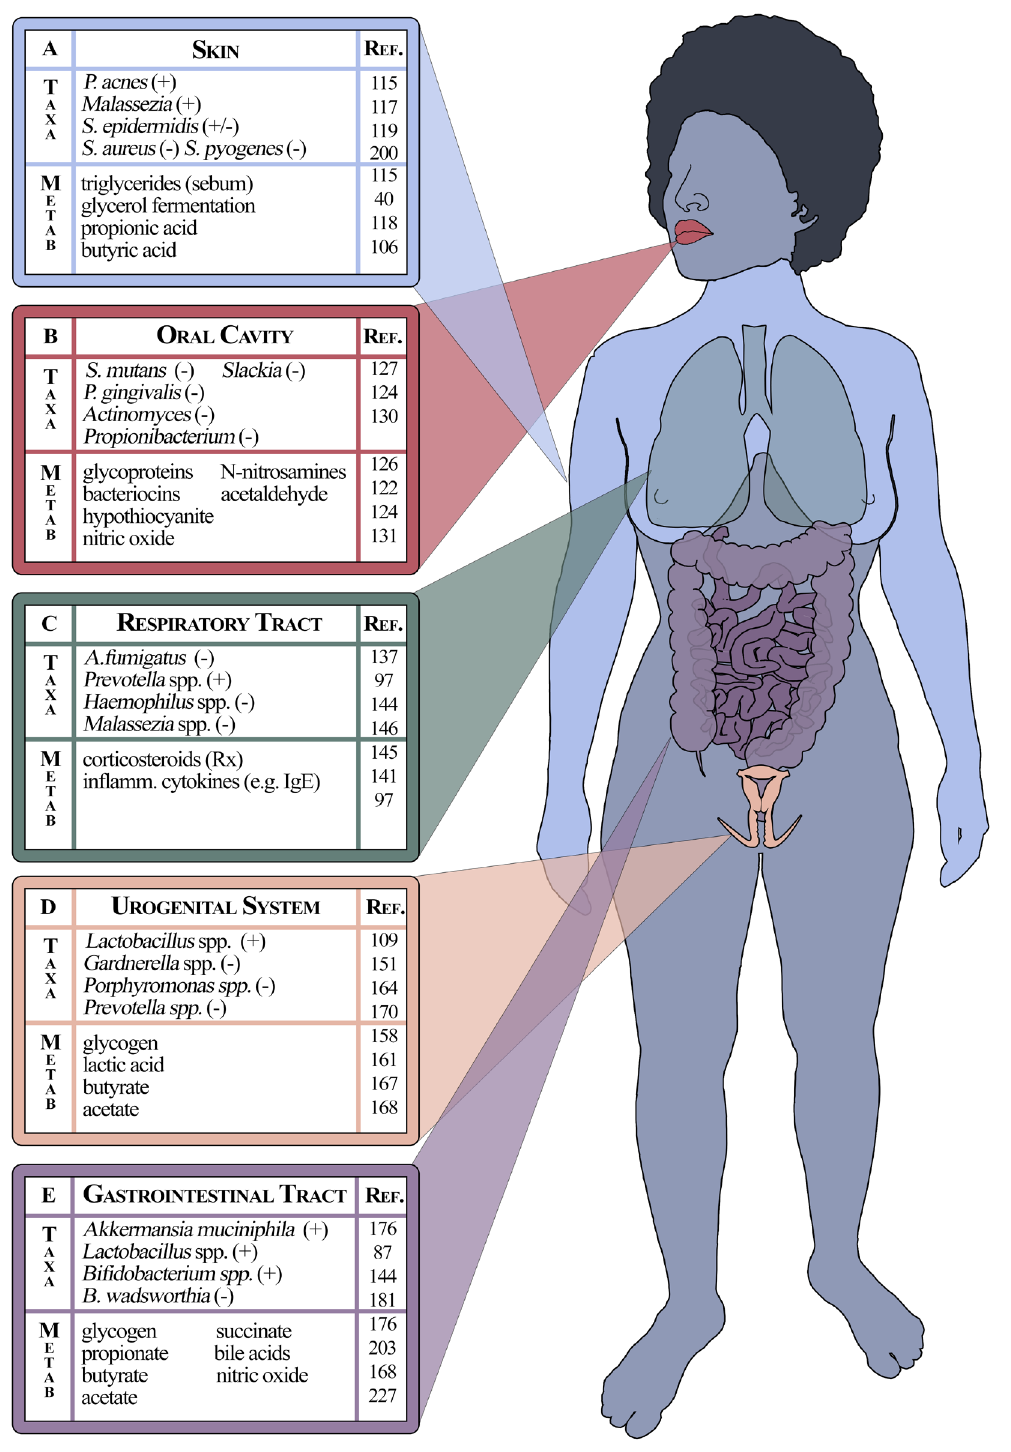
Figure 1. Demonstration of key microbiota and metabolites of the human microbiome, delineated according to human physiology. (A) The skin, (B) oral cavity, (C) respiratory tract, (D) urogenital system and (E) gastrointestinal tract are each highlighted with examples of microbiota (Taxa) and relevant metabolic activity (Metab). Beneficial associations to host health are denoted as (+) and negative associations as